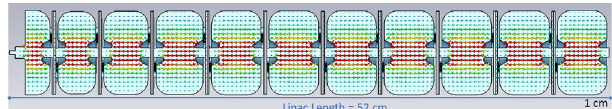
FIG. 4. Electric field vector plot of the π = 2 operation mode.